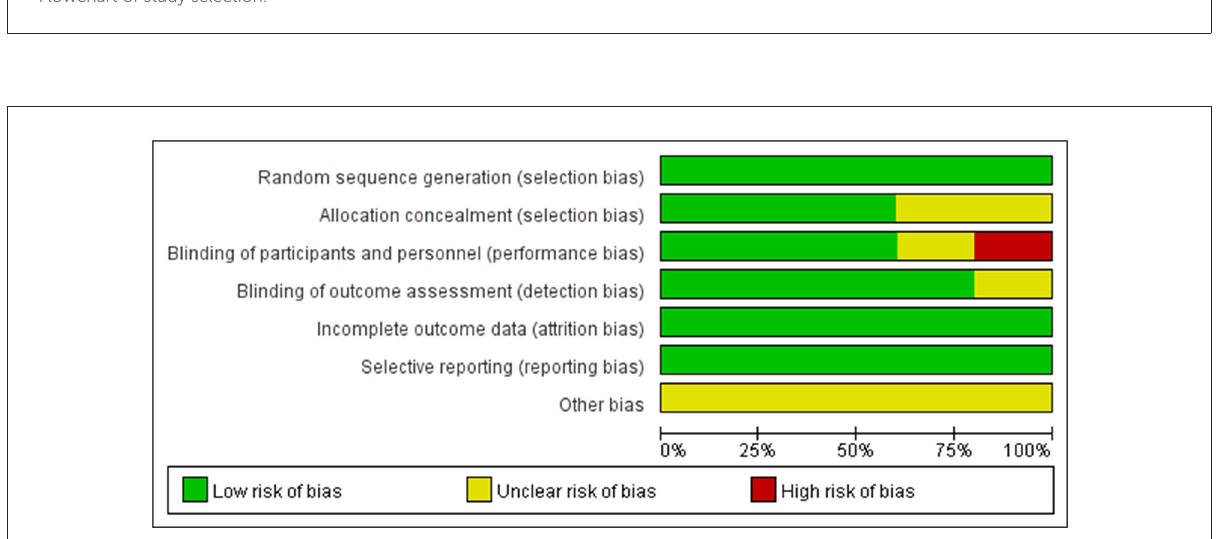
FIGURE2 Risk of bias